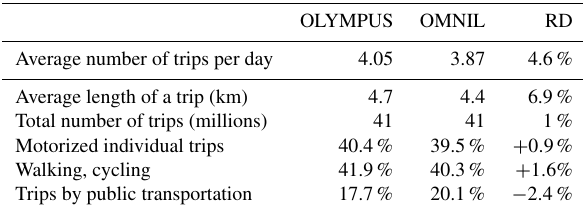
Table 2. Comparison of mobility with global transport